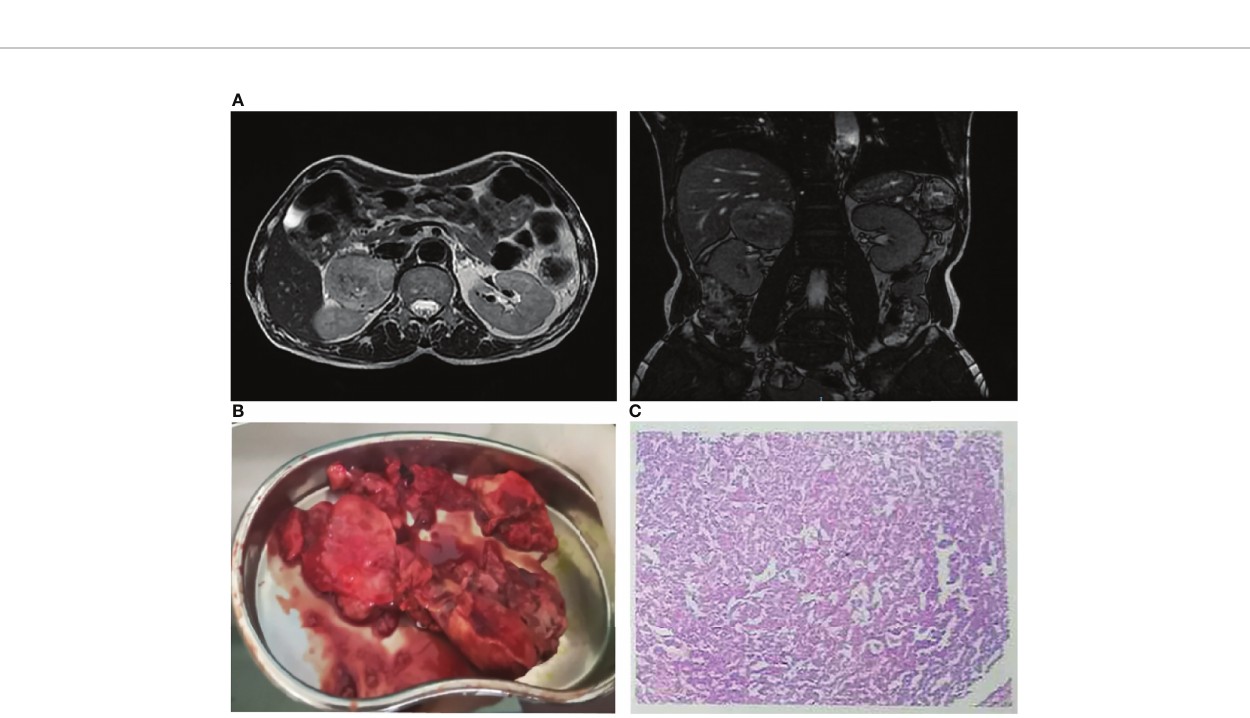
FIGURE 3 | (A) Magnetic resonance imaging demonstrated a 68 x 61 mm mass in the right adrenal gland. (B) Right adrenalectomy was performed to remove a huge pheochromocytoma. (C) Pathological examination showed pheochromocytoma.